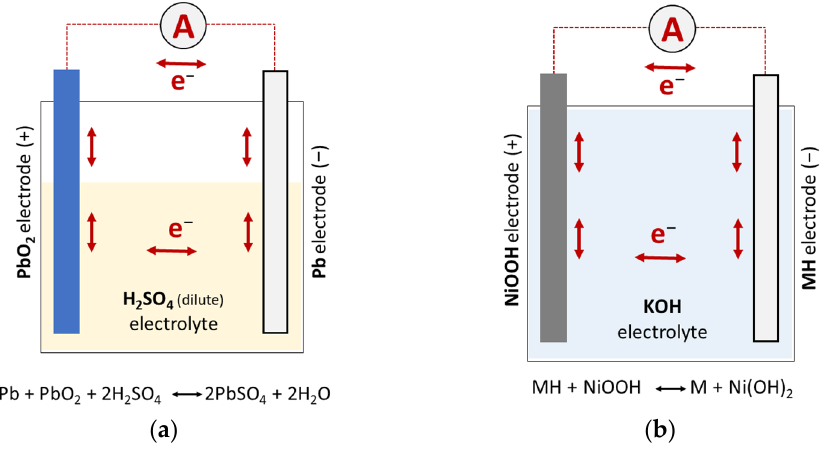
Figure 7. Composition of battery cell (traditional generation). ( a ) Lead-acid cell. ( b ) Ni-MH cell.